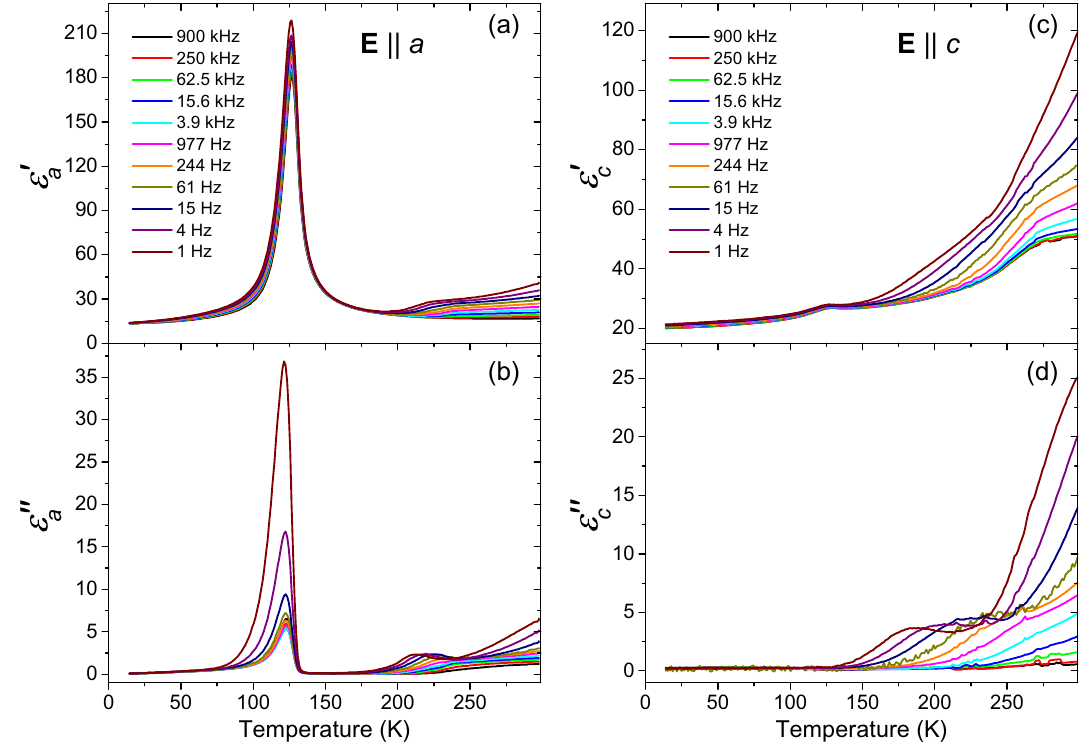
Figure 1. Temperature dependences of the complex permittivity ˆ ε a , ˆ ε c at selected frequencies. Panels ( a , c ): real parts, panels ( b , d ): imaginary parts.